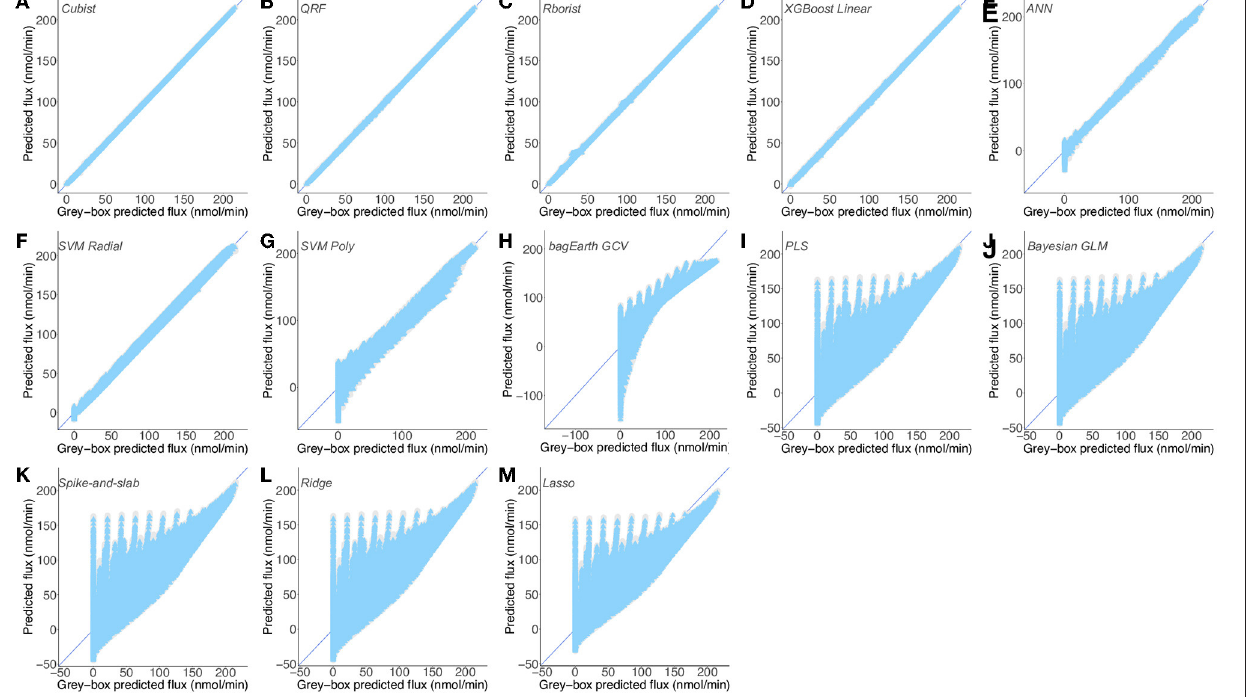
Frontiers in Artificial Intelligence |